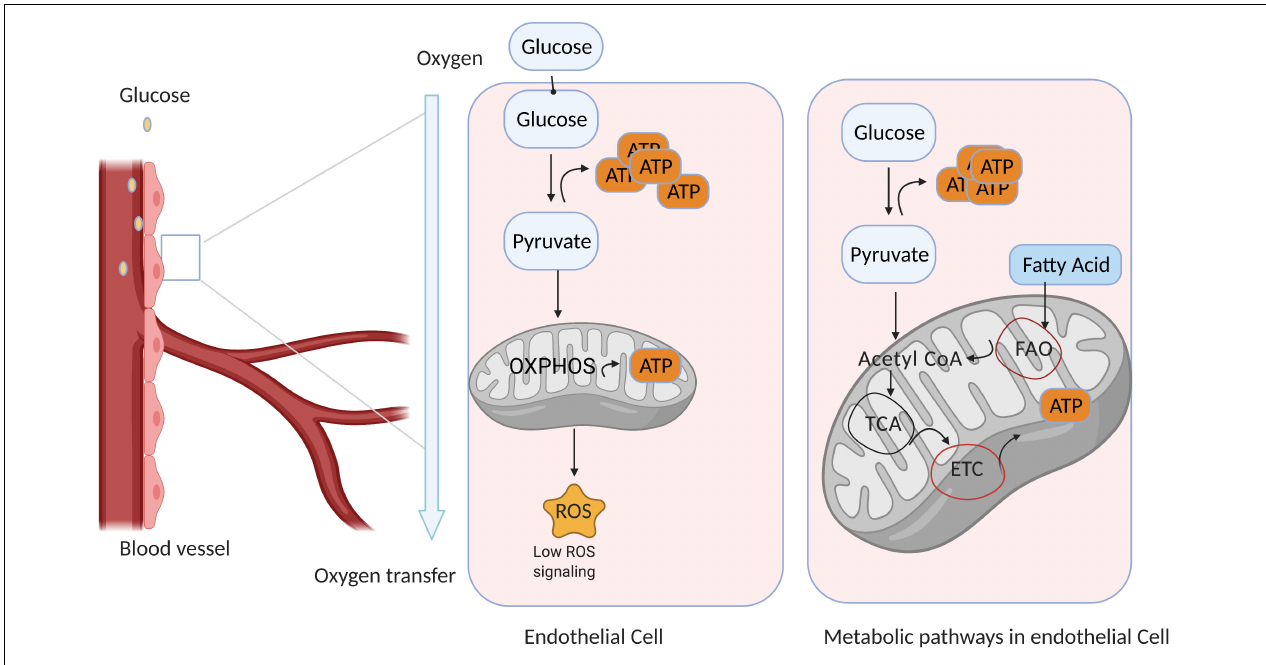
FIGURE 1 | Endothelial cell (EC) metabolism is dominated by glycolysis. Quiescent ECs line the blood vessels and generate most of their ATP via glycolysis; however, a small amount of ATP is generated via mitochondrial metabolism, which also produces reactive oxygen species (ROS) that participate in signal transduction. Thus, ECs consume only a small amount of oxygen, and the remainder is available to support the activity of perivascular cells. ( Right ) ECs use glycolysis as the primary source of ATP generation, while other metabolic pathways are used in different conditions and often context